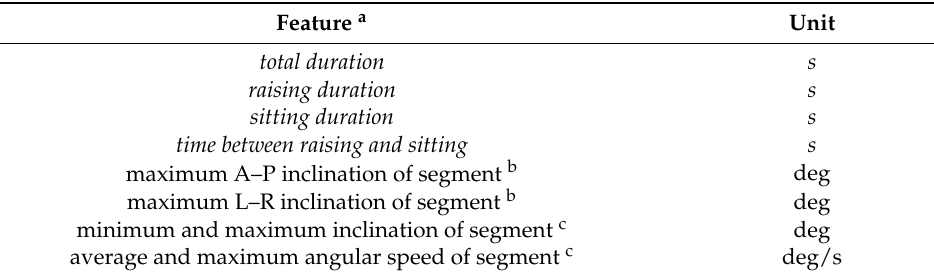
Table 1. Features computed during SWAP 4 and SWAP